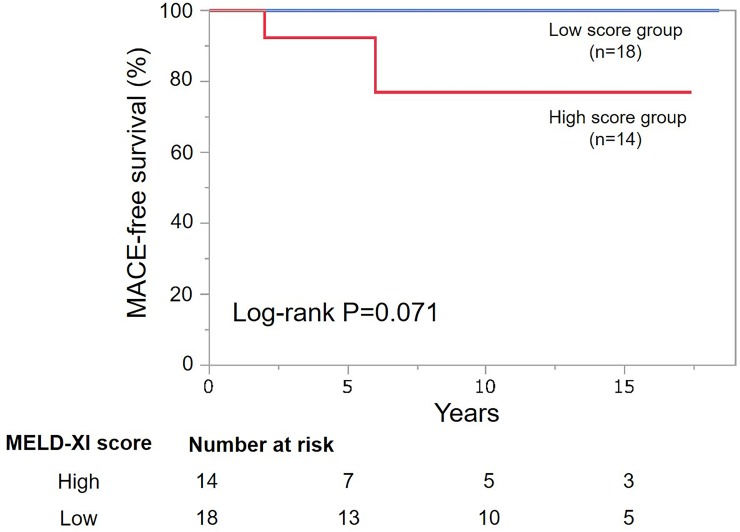
Kaplan-Meier curves for a subgroup of patients with Fontan circulation.MACE-free survival was not significantly different between the high and the low score groups (log-rank, P = 0.071). MACE, major adverse cardiac events; MELD-XI, model for end-stage liver disease excluding international normalized ratio.